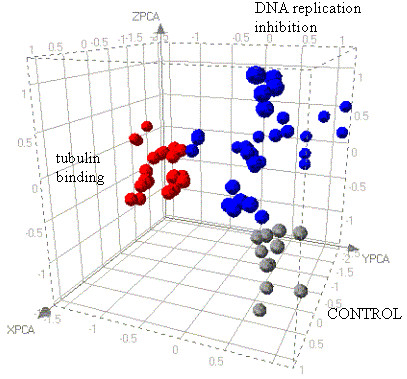
Spotfire scatter plot for the three-dimensional principal component analysis of the training set used for supervised classification, in the data set compound_panel-517RmedNR_feature_sel_FILTER_60_moa.CVEC, generated after data streaming to Spotfire. Samples are color coded in accordance to mechanism of action of the compound treatment, as indicated in the plot.